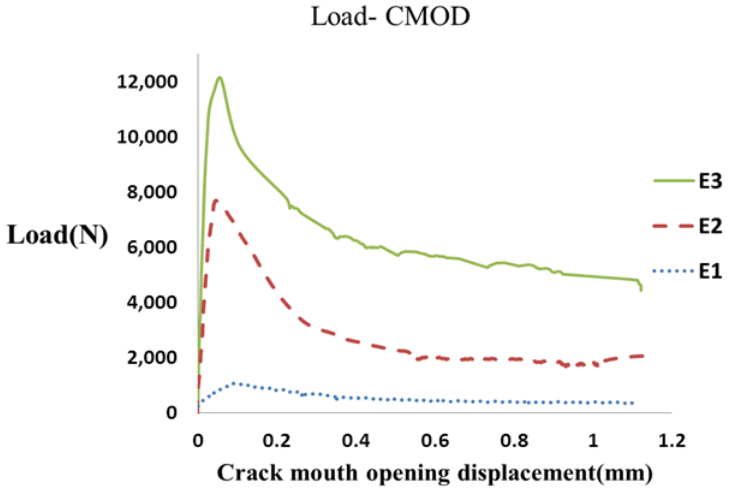
Figure 4. The load – CMOD curve obtained for fiber-reinforced concrete specimens with different thicknesses.